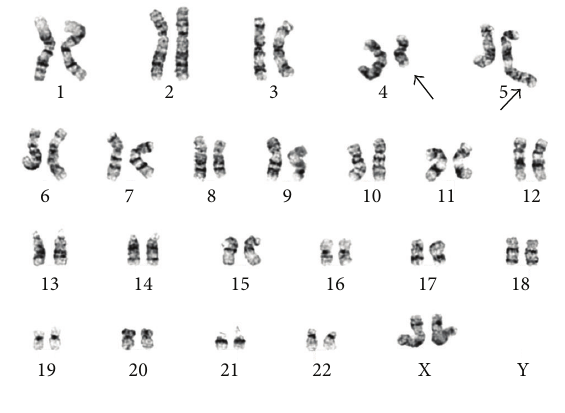
Figure 2: Representative G-banded karyogram showing t(4;5)(q21;